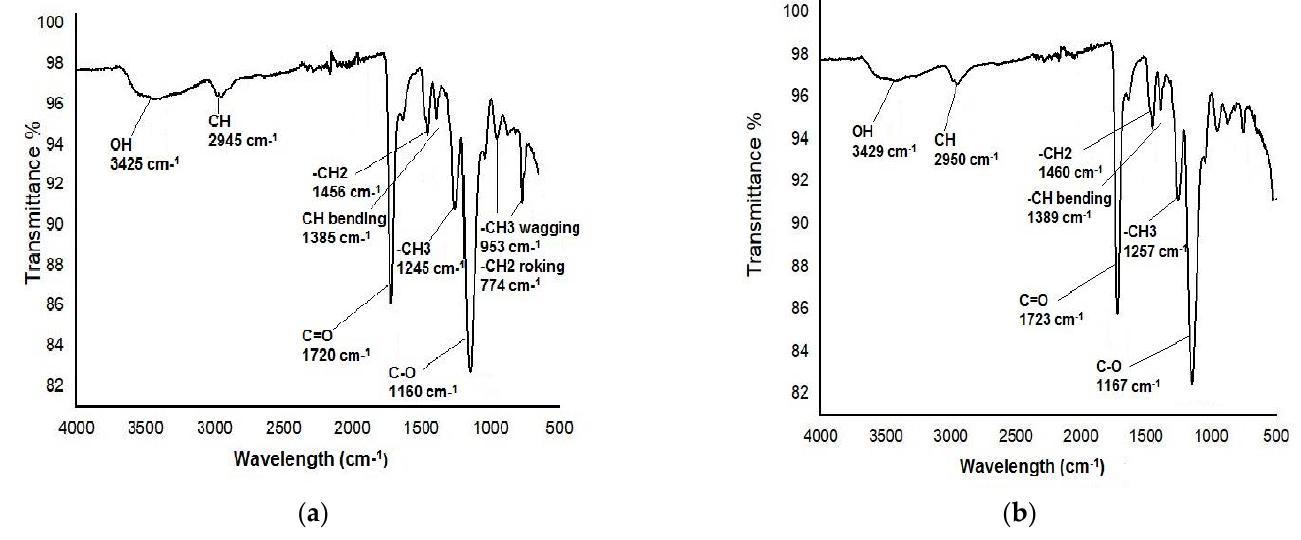
Table 1. BET analysis of